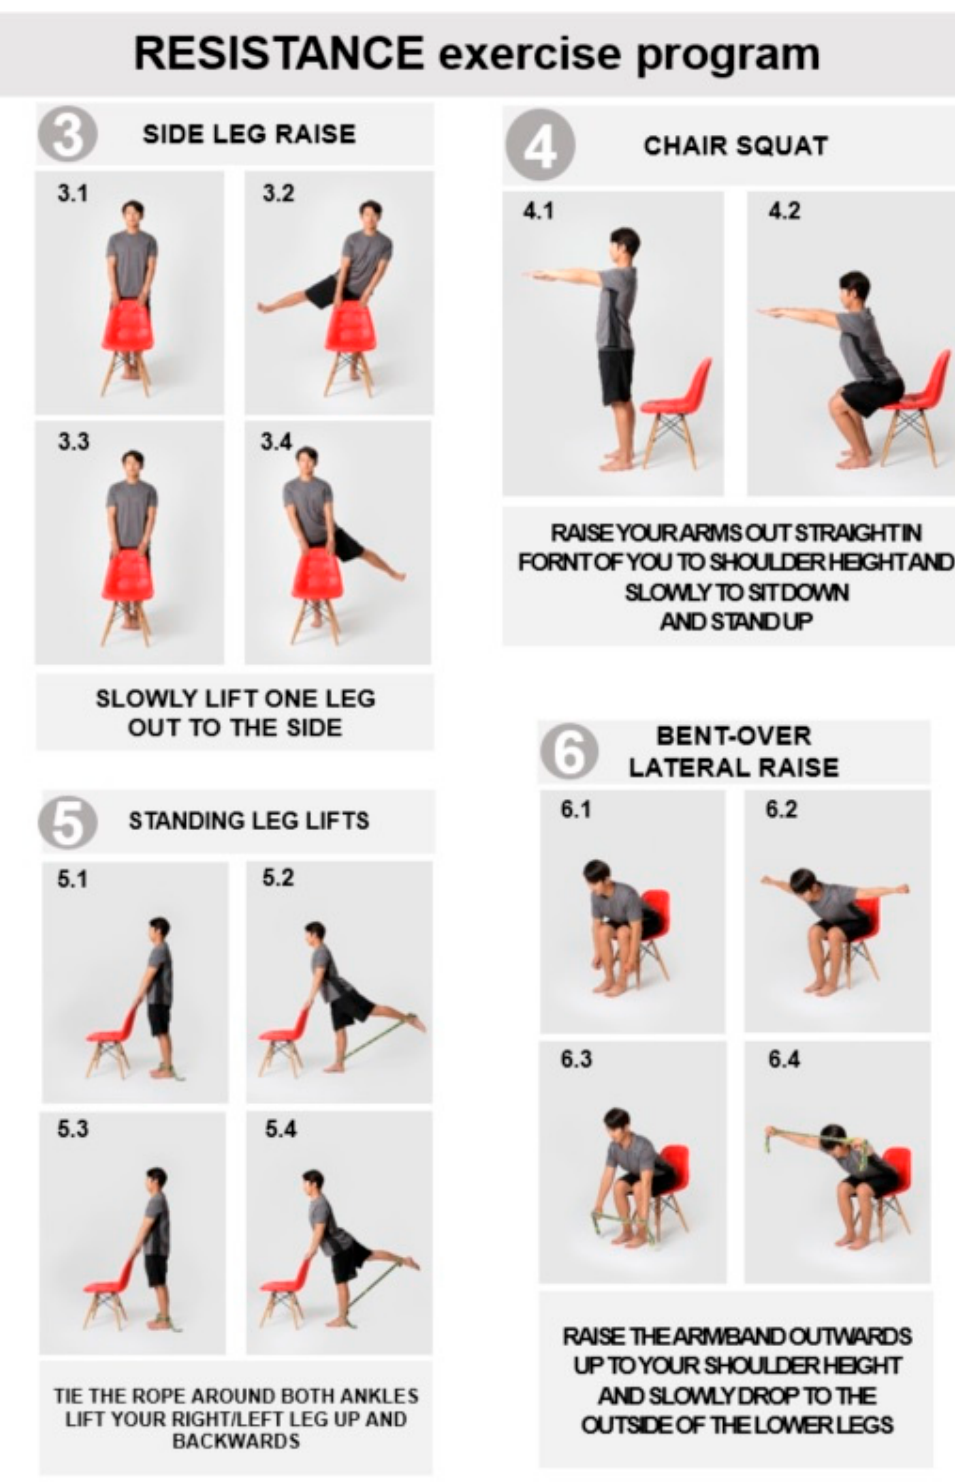
Figure A12. Detailed description and components of each movement in the “Chair routine part 2” resistance exercise.